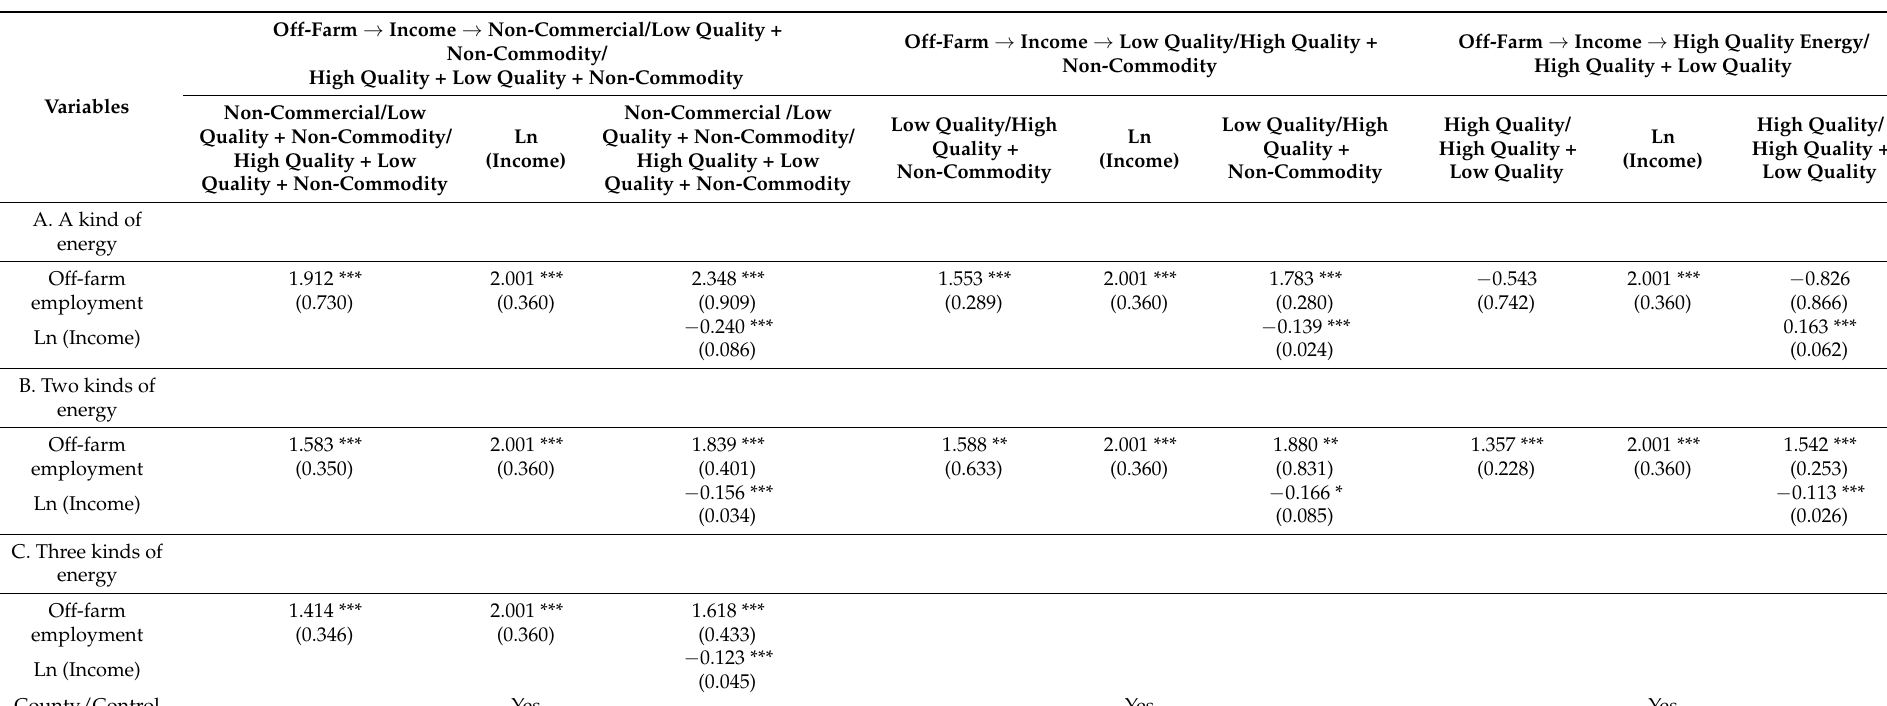
Table 5. Mechanism of the impact of Off-farm employment on several types of energy use: annual household cash income.